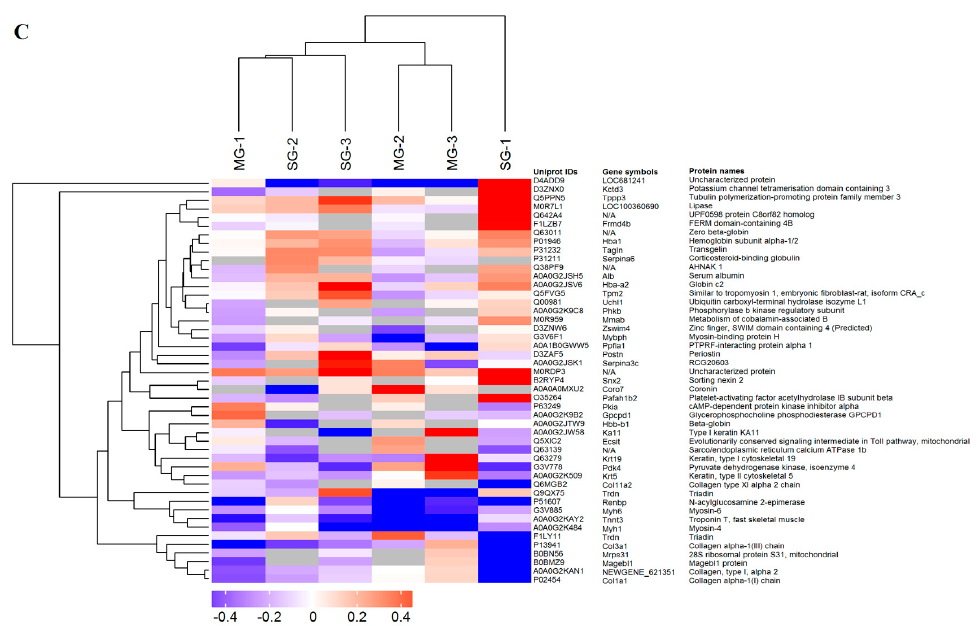
Figure 3. Hierarchical clustering of differently expressed proteins between SDG and model group (MG) ( A ), SDG and SG ( B ), SG and MG ( C ) groups, n = 3 samples for each group (3 data points for each bar), each consisting of tissue of 4 rats. Euclidean distance algorithm for similarity measurements and an average linkage clustering algorithm for clustering were selected. A heatmap was created as a visual aid, in addition to the use of a dendrogram. Each column represents one biological replicate. Each row represents one significant protein. The relative expression level was indicated using the intensity of each color. Red, blue, and gray colors indicate a relative increase, decrease, or no quantitative information in protein content for a particular protein, respectively (row).